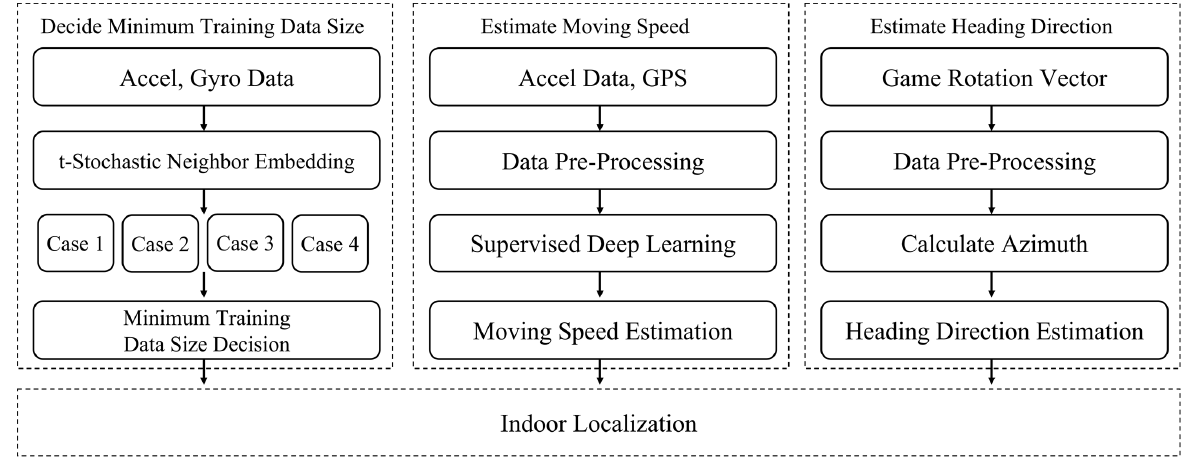
Figure 3. Indoor localization system